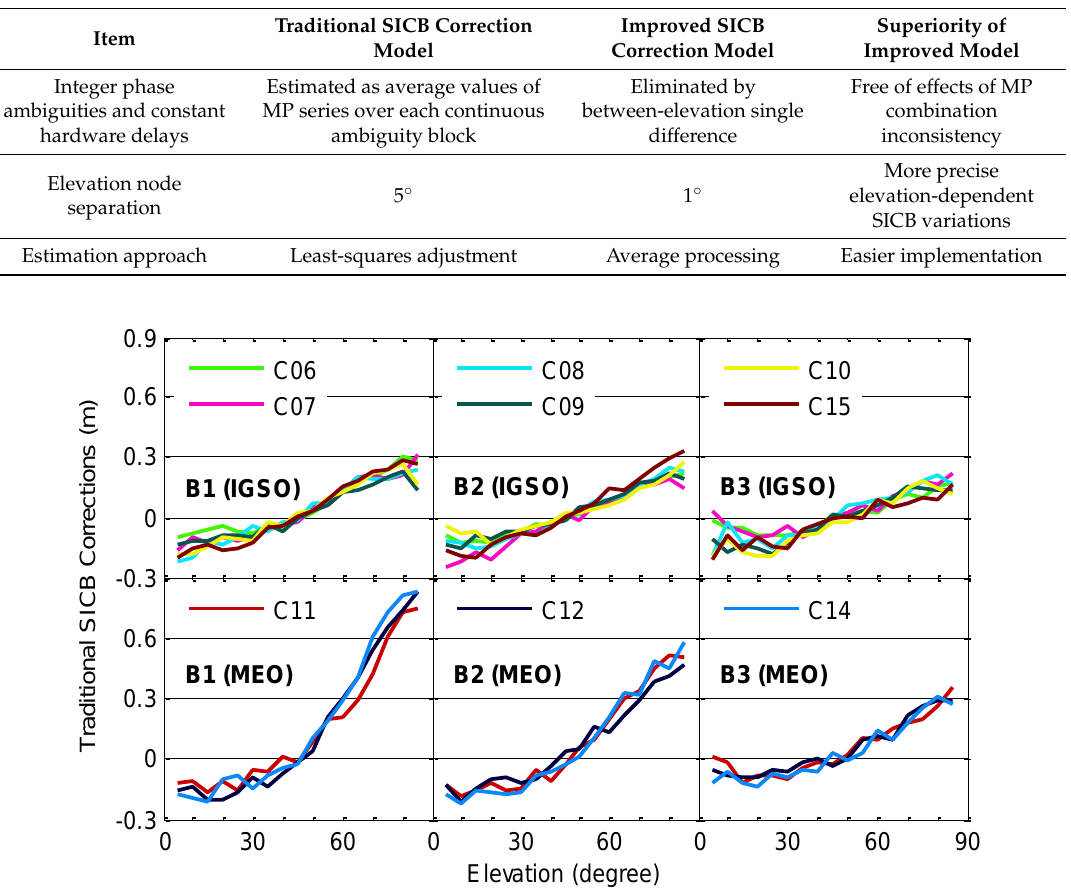
Figure 15. Traditional SICB correction model as a function of elevations on B1, B2 and B3 frequencies for each BDS-2 MEO and IGSO satellite.